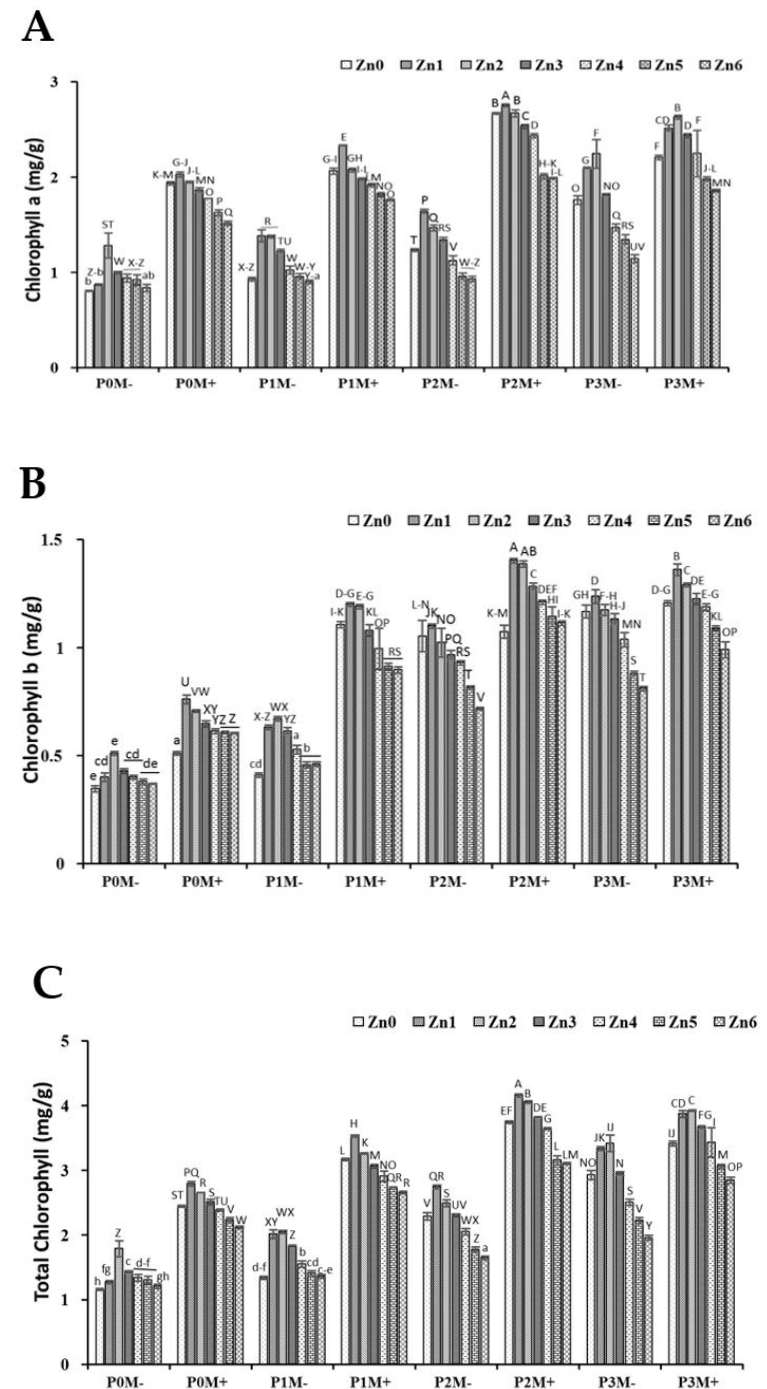
Figure 2. Chlorophyll a ( A ), b ( B ), and total chlorophyll content ( C ) in the maize leaves grown under various P (0, quarter, half and full recommended dose) and Zn (0, 20, 40, 60, 80, 100 and 120 mg Zn/kg soil) application rates under AM and NM conditions. Mean values are presented ± standard error (SE). Different letters on the bars indicate significant differences at p ≤ 0.05. Capital letters indicate the highest values. After completely using uppercase letters up to Z, lower case letters are used to show the decrease of mean values. P1 = 14.5 kg, P2 = 29 kg, P3 = 58 kg; Zn control = 0, Zn1 = 20, Zn2 = 40, Zn3 = 60, Zn4 = 80, Zn5 = 100, and Zn6 = 120 mg Zn kg − 1 .